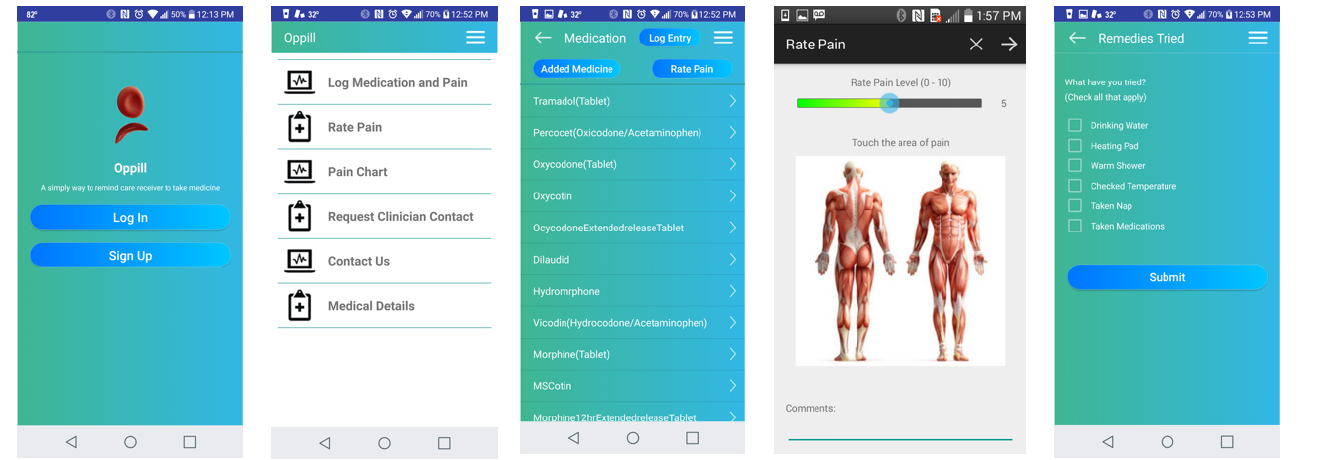
Figure 1. OpPill Application Screenshots.